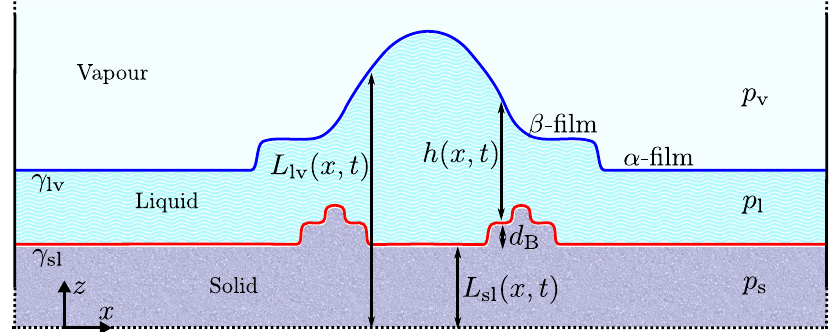
Fig. 2 Illustration of a possible surface feature with annotations for our two-dimensional gradient dynamics model setup. Two evolving interfaces are shown: the solid – liquid surface (lower solid red line) at reference height z = L sl ( x , t ) and above the liquid – vapor interface (upper solid blue line) at reference height z = L lv ( x , t ). The solid and vapor phases are modeled as extending in fi nitely below and above,